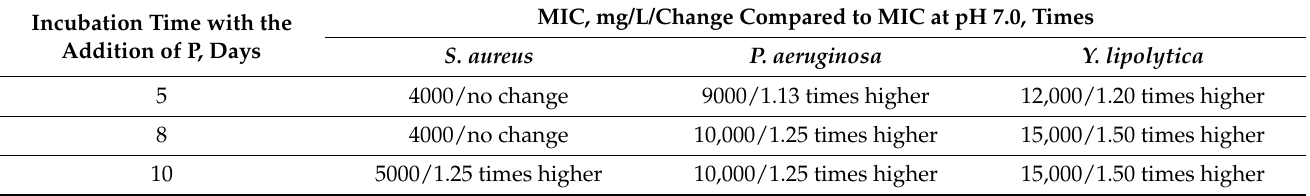
Table 5. Changes in the MIC of sodium percarbonate for test-microorganisms during long-term incubation. MIC, mg/L/Change Compared to MIC at pH 7.0,